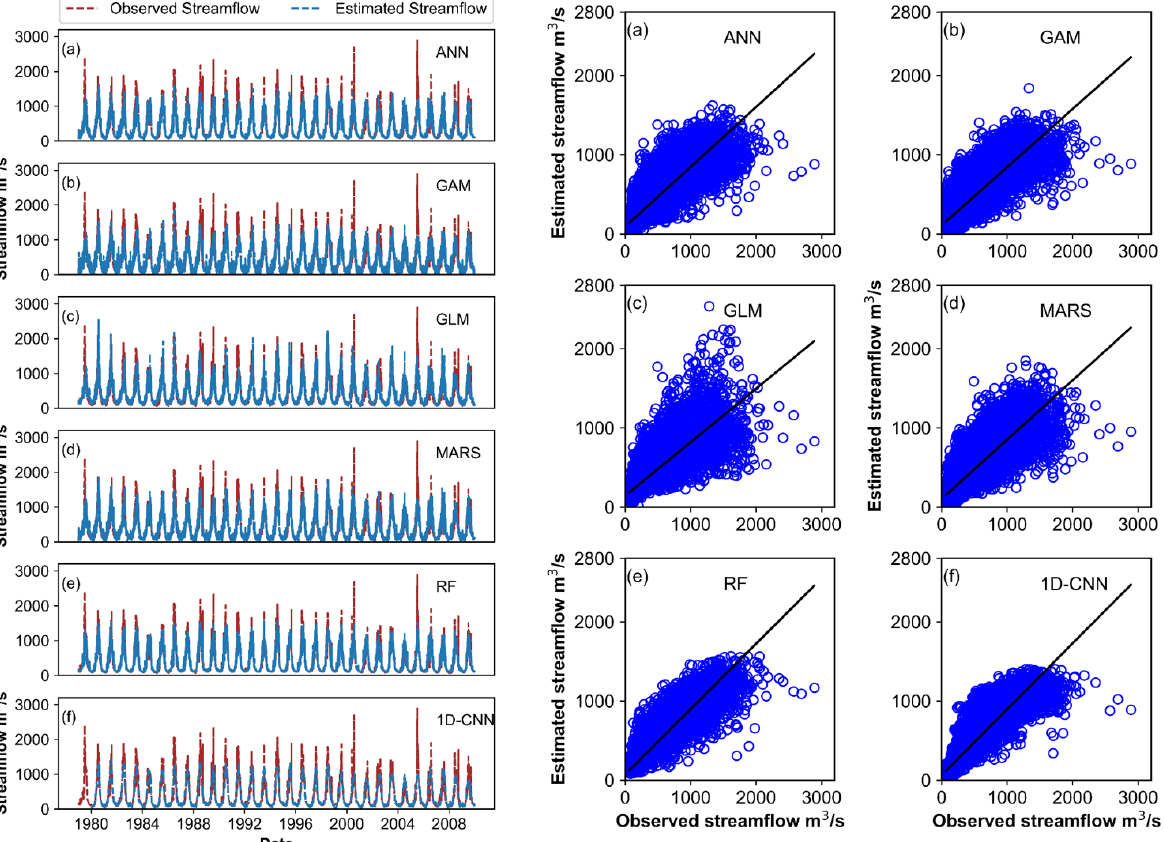
Figure 7. Comparison of observed and simulated streamflow for all six models (ANN, GAM, GLM, MARSs, RF, and 1D-CNN) under rainfall scenarios R 2